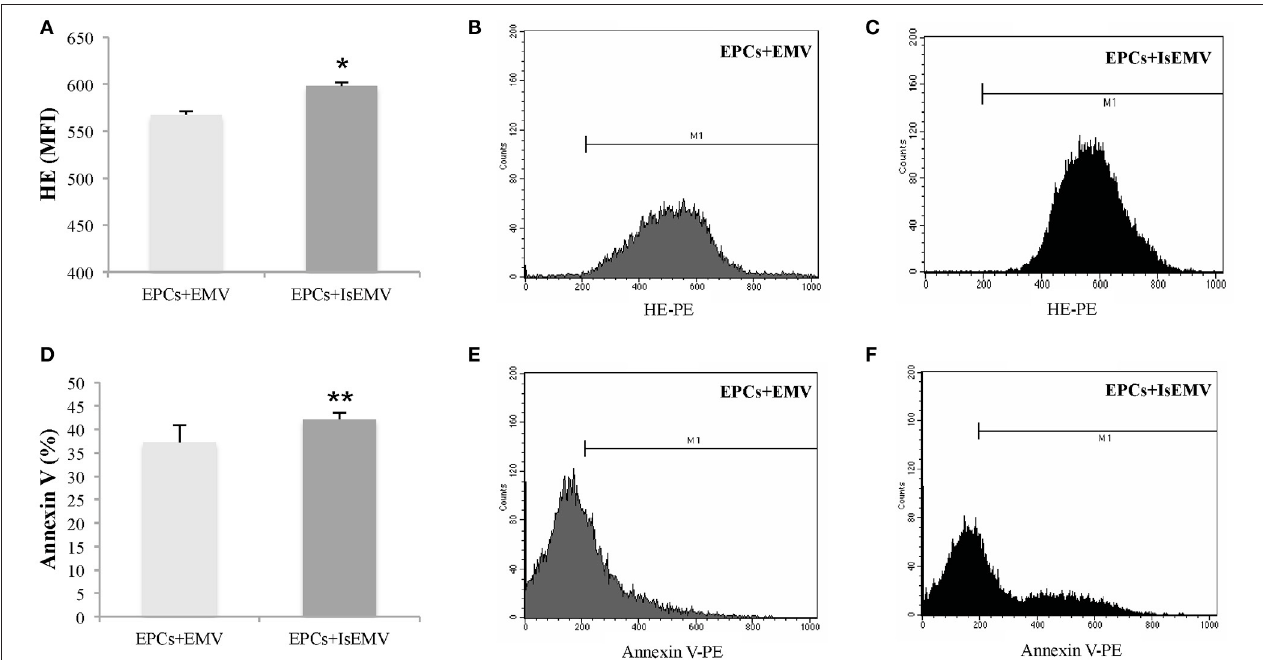
FIGURE 5 | Effect of microvesicles (MV) on endothelial progenitor cells (EPCs). EPCs obtained from healthy donors were treated with MV derived from IS-treated HUVECs (IsEMV) or untreated HUVECs (EMV) for 14 days. The treatment with IsEMV increased markers of oxidative stress and apoptosis. (A) Hydroethidine (HE) expression analyzed by flow cytometry of EPCs treated with EMV or IsEMV. The expression was quantified by changes in the mean fluorescent intensity (MFI). Representative images of flow cytometry of HE expression in EPCs treated with (B) EMV and (C) IsEMV, M1 bars indicate cells positive for HE expression. (D) Differences in the percentage of annexin V in EPCs observed by flow cytometry in cultures treated with EMV or IsEMV. Representative images of flow cytometry of annexin V in EPCs treated with (E) EMV and (F) IsEMV, M1 bars indicate cells positive for annexin V expression. Results are the mean ± SEM of three independent experiments. * p < 0.004 vs. EPCs treated with EMV; ** p = 0.045 vs. EPCs treated with EMV.